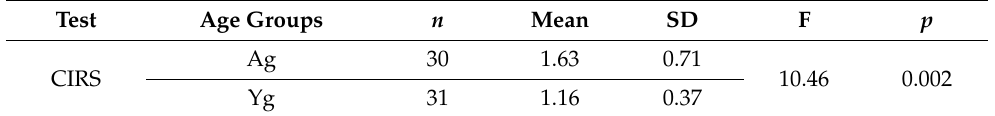
Table 3. Group description data and one-way ANOVA statistical analysis.